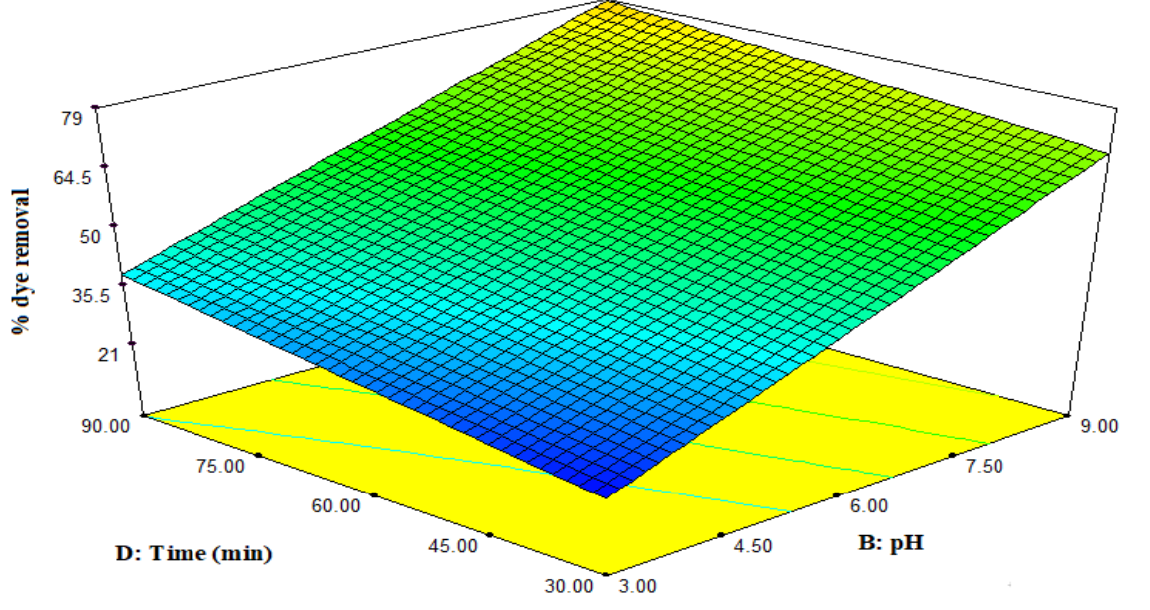
Figure 15. Interaction effect between the solution pH (B) and contact time (D) on the perecentage dye removal at a constant initial dye concontration (A) of 38.19 (mg/L) and adsorbent dose (C) of 200 (mg/L).